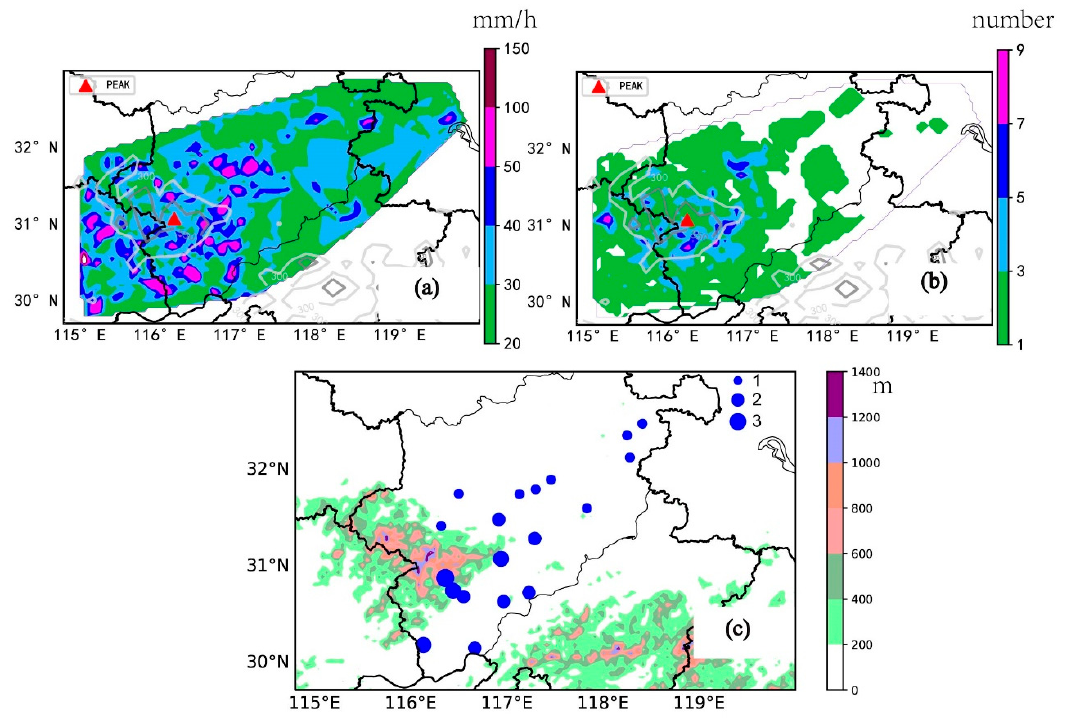
Figure 8. ( a ) The maximum hourly precipitation (shaded, unit: mm/h), ( b ) the frequencies of SDHR (shaded, unit: number), and ( c ) frequencies (unit: number) of THWs of LCDM during the warm seasons (from April to September) of 2014–2018. The contours represent elevations (unit: m) in ( a ) and ( b ), and the shaded represent elevations (unit: m) in ( c ).